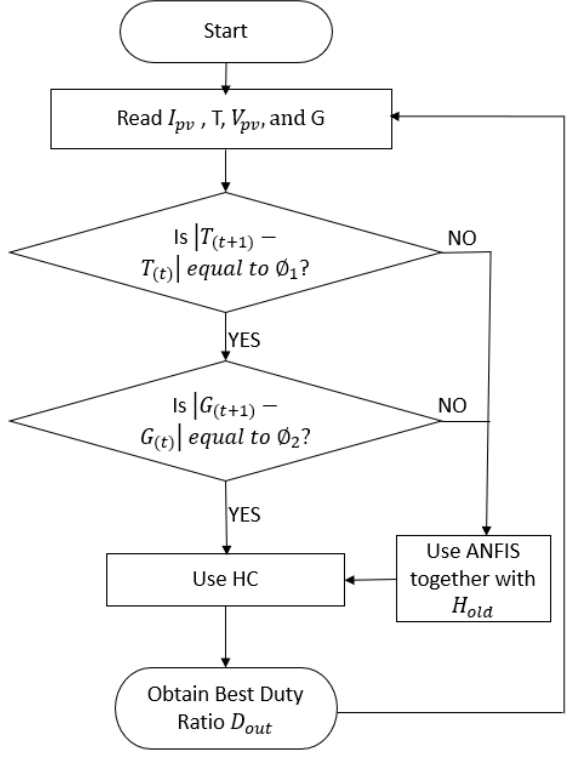
Figure 6. Flow diagram of the HC ‐ ANFIS MPPT technique [44] .